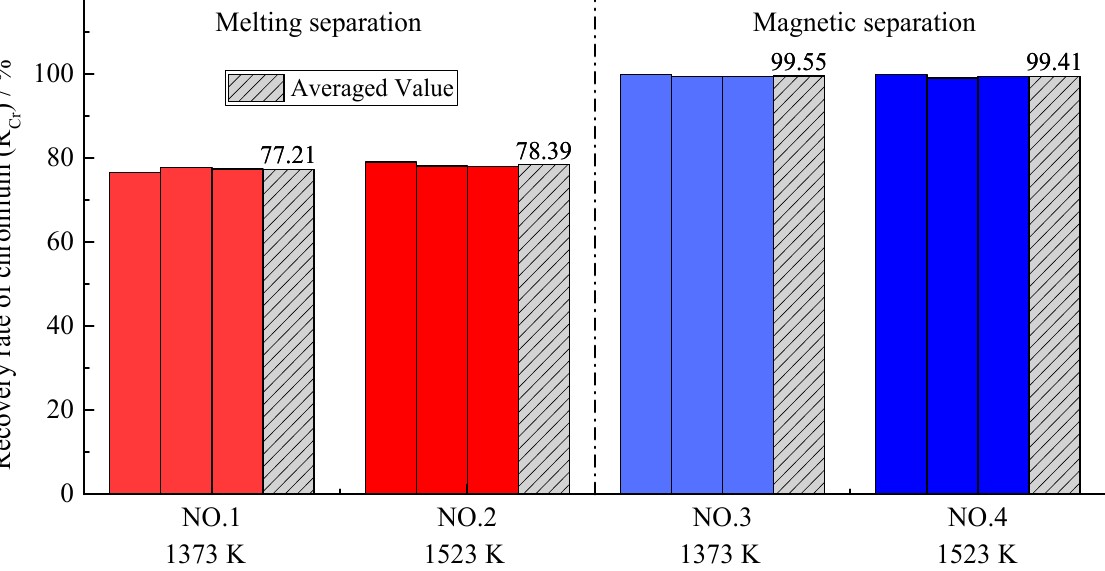
Figure 9. Recovery rate of chromium with different pre-reduction temperatures and different separation processes.